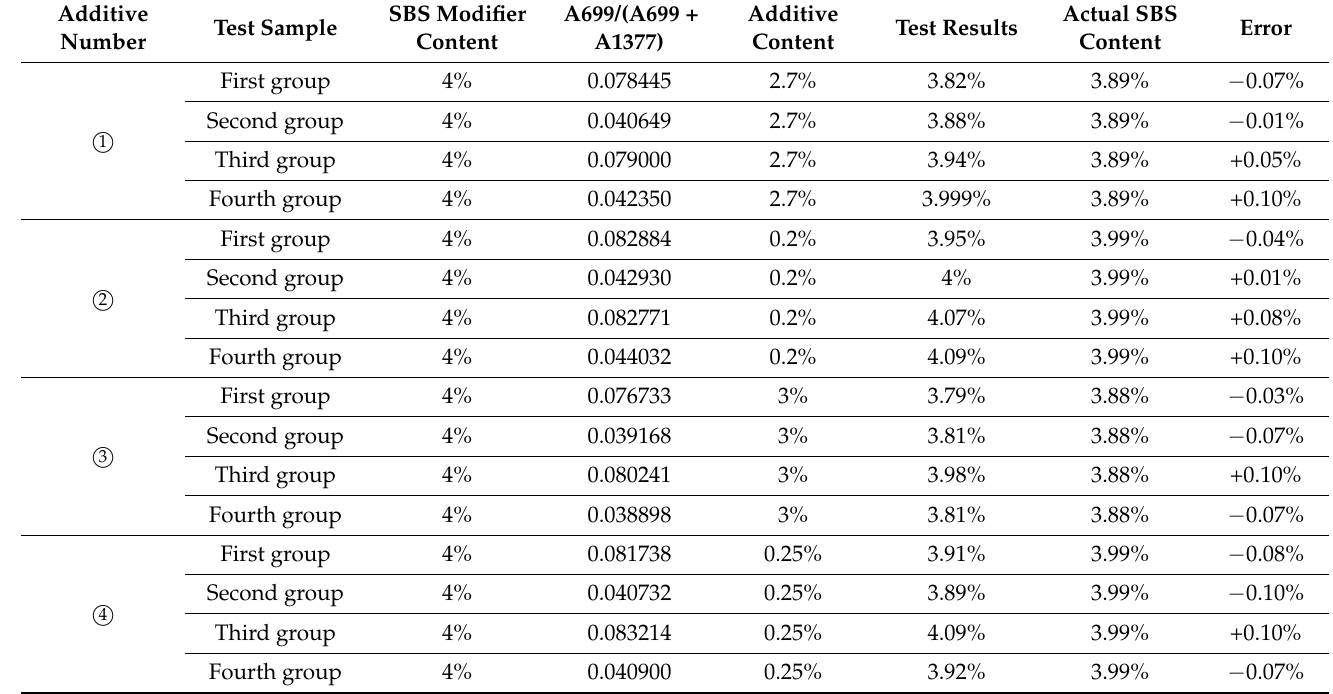
Table 10. Test results of SBS-modified asphalt with